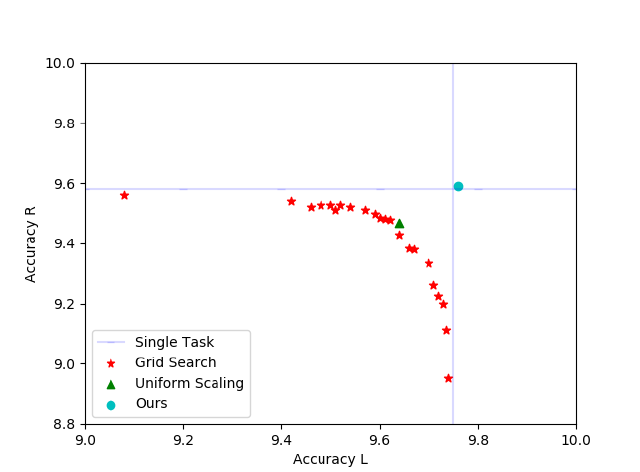
Figure 3. Diagram of MultiMNIST accuracy.